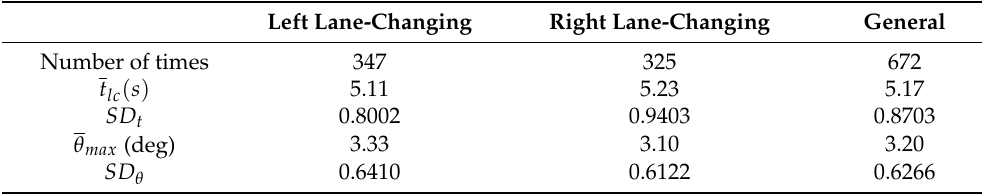
Table 1. Results of driving simulation lane-changing experiment. Left Lane-Changing Right